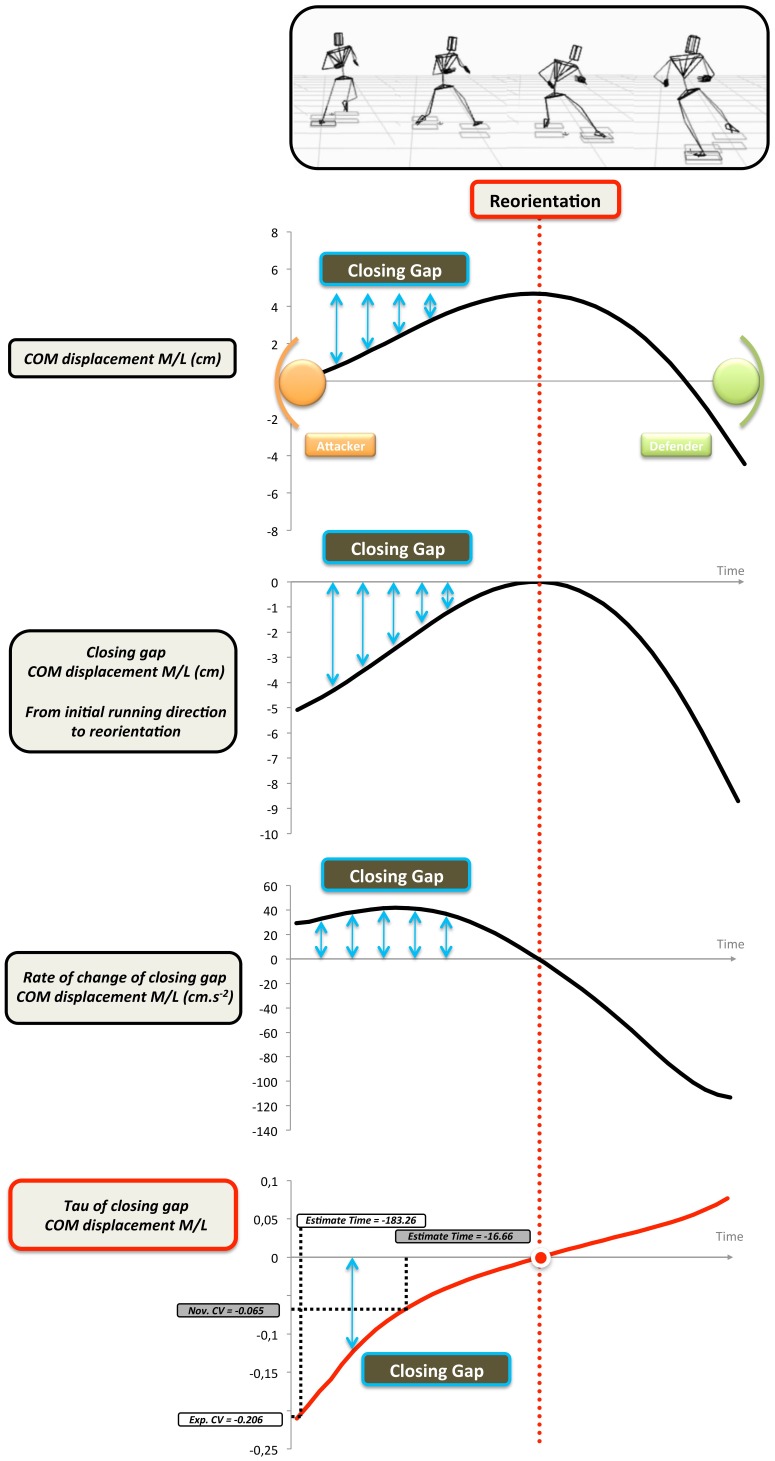
Example of the Tau COM displacement medio-lateral (M/L) for a DM to the right.This figure shows an example of how Tau of closure of the COM M/L displacement gap is calculated to detect the point of reorientation. In this example, the closing motion-gap (top panel) is defined as the difference between the initial running direction and the maximal medio-lateral displacement (which corresponds to the reorientation peak symbolized by the vertical red dotted line). For the other angle parameters, such as upper trunk yaw, the same procedure is used but the gap is closed from the initial orientation before the DM (straight run ∼0°) to the point of maximal orientation (i.e. the reorientation peak for this parameter). The middle panel shows the rate of change of the COM displacement towards the point of reorientation and the bottom panel shows the tau of the COM displacement. On the bottom graph the critical values (CVs) are presented for both experts (Exp. CV) and novices (Nov. CV). These values represent the time when the information becomes most important. Note how it is much sooner for the experts than the novices.